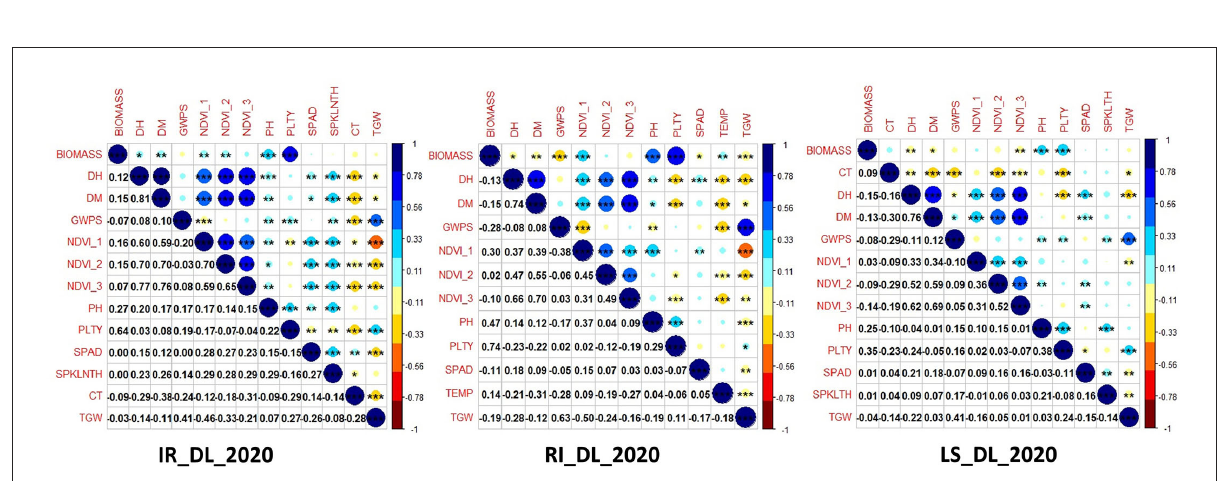
FIGURE2 Correlation among the studied traits in the GWAS panel evaluated at IARI Delhi under three conditions, viz ., IR, RI and LS during